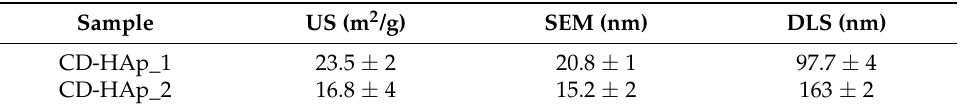
Table 3. Parameter comparison of mean particle size resulting from DLS, SEM studies and measurements. ultrasonic